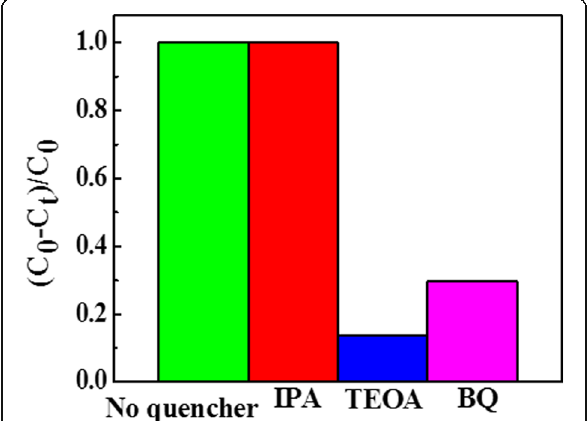
Fig. 7 Trapping experiments of active species during the photocatalytic